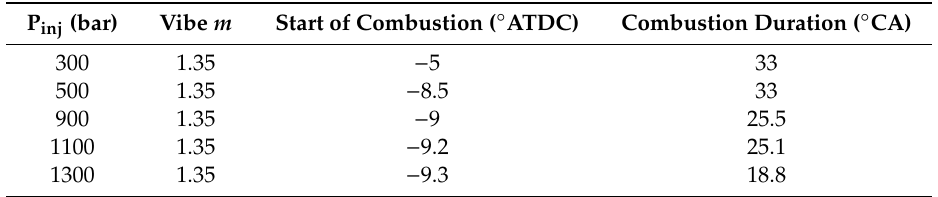
Table 5. Vibe coe ffi cient m and combustion